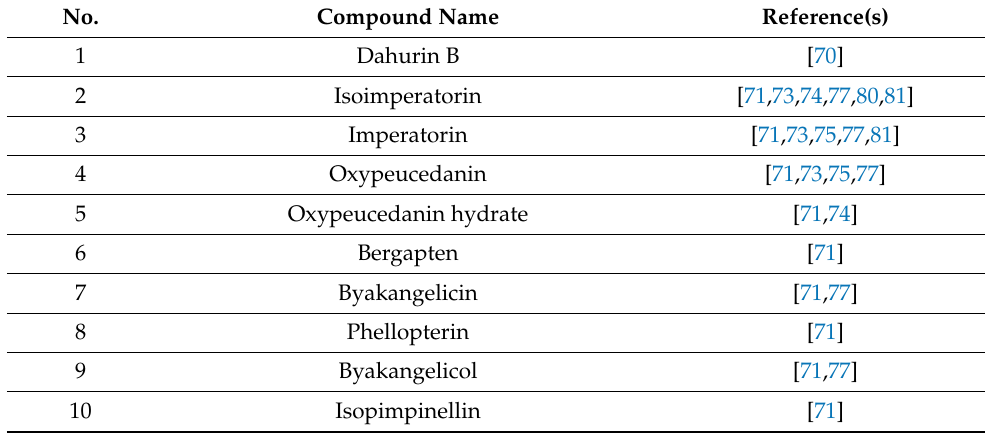
Table 3. Coumarins and furanocoumarins isolated from Angelica dahurica